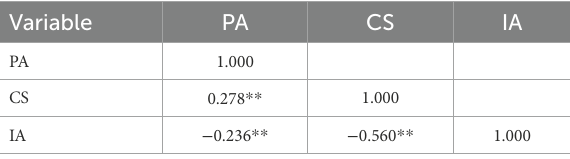
TABLE 4 Results of the correlation analysis of PA volume, CS and IA for university students.